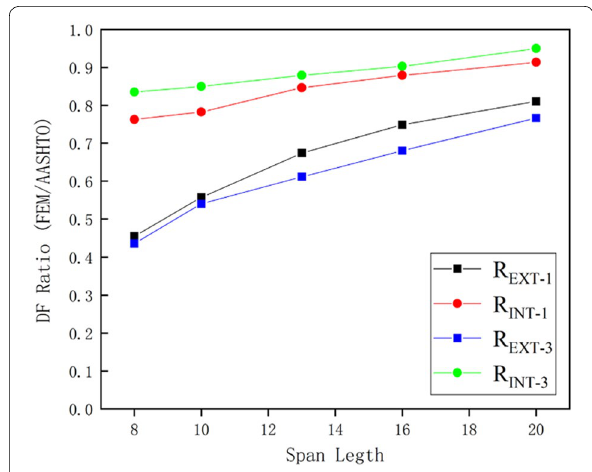
Fig. 15 FEM/AASHTO ratio for length parameter. Note: R EXT-i : DF ratio of exterior girder in i loaded lane; R INT -i: DF ratio of interior girder in i loaded lane.